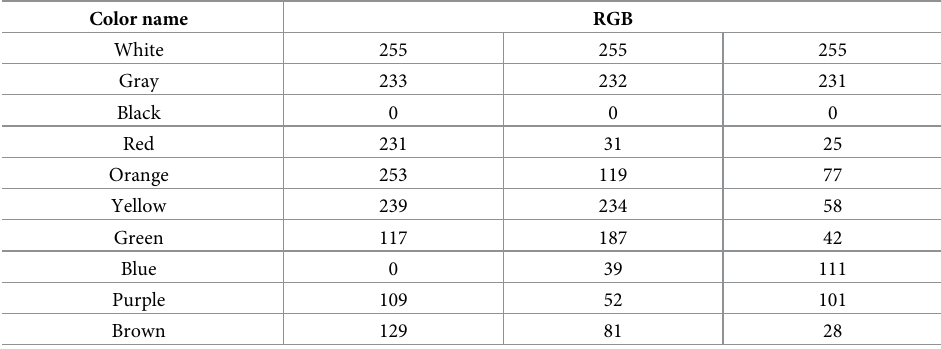
Table 3. Main 10 colors RGB.